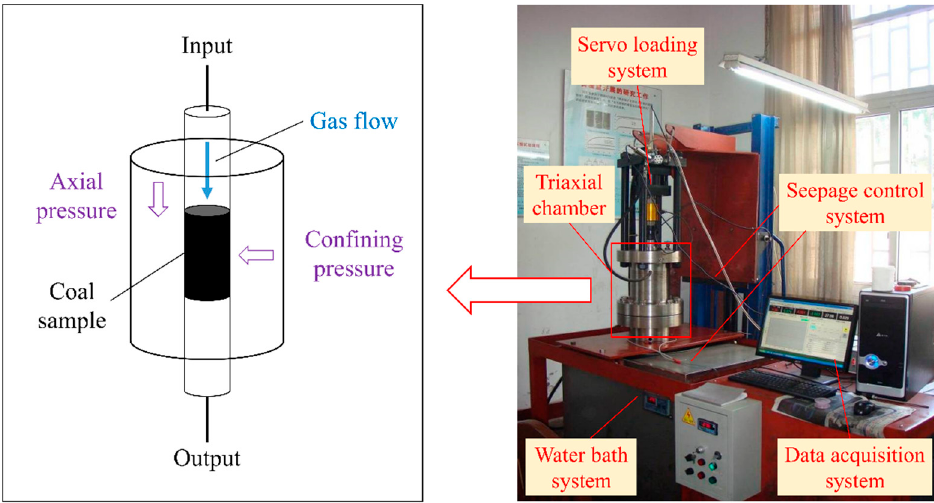
Figure 1. Experimental apparatus for mechanical-seepage coupling experiments. Table 1. Proximate analysis of coal samples.